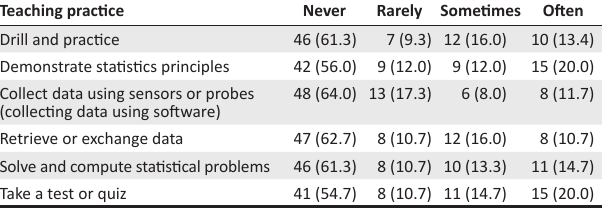
TABLE 4: Exploration of the use of technology in teachers’ practice. Teaching practice